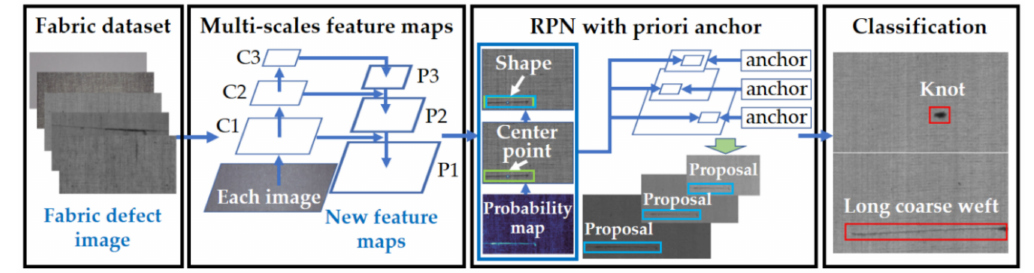
Figure 1. The fabric defect detection process of the